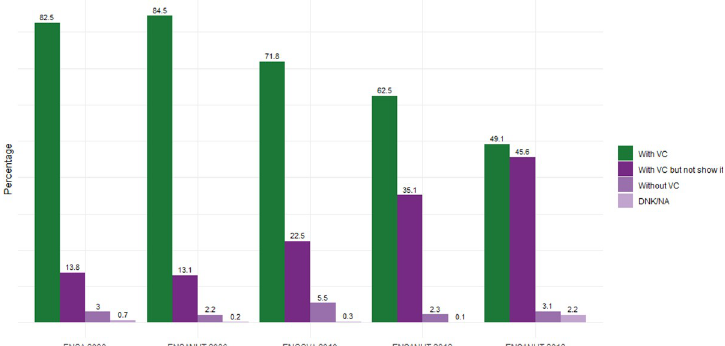
Fig 1. Information type trend provided by national health surveys, Mexico 2000–2018. VC, Vaccination Card; DNK/NA, Does not know, No answer. Acronyms in Spanish: ENSA, Encuesta Nacional de Salud (National Health Survey); ENSANUT, Encuesta Nacional de Salud y Nutricio´n (National Health and Nutrition Survey); ENCOVA, Encuesta Nacional de Cobertura de Vacunacio´n (National Coverage